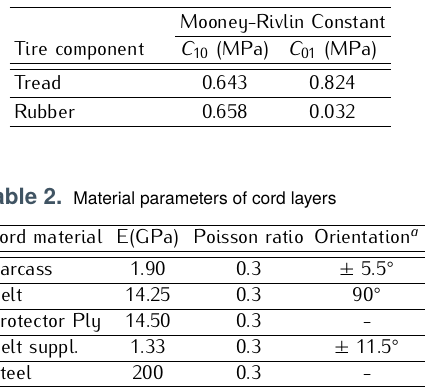
Table 1. Material parameters of rubber